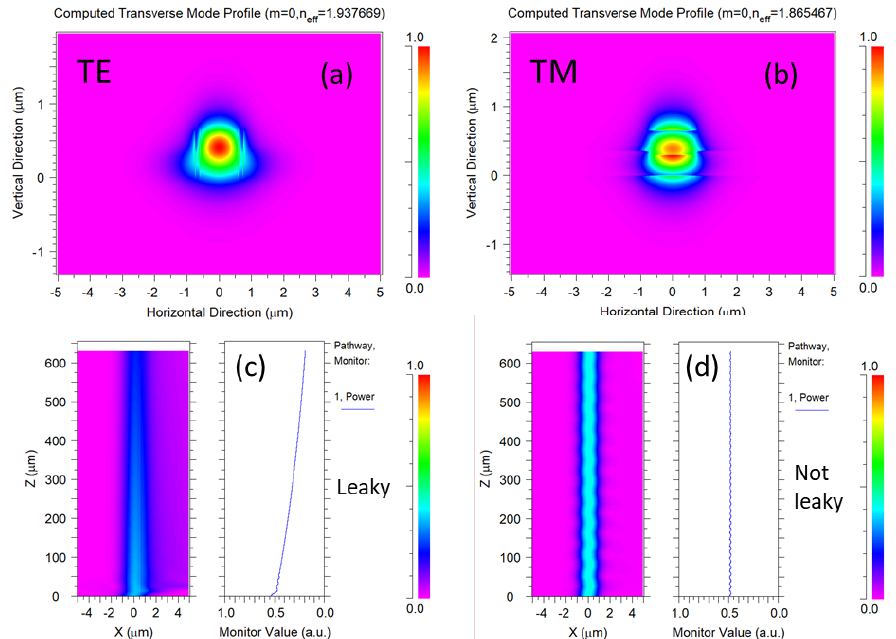
Figure 3. Electromagnetic simulations of TE and TM fundamental modes and their propagation from silica buried SiOC-coated Si 3 N 4 waveguide with a bend radius of 100 µ m ( a ) TE mode ( b ) TM mode ( c ) propagation of TE mode that is leaky and ( d ) stable propagation of TM mode.